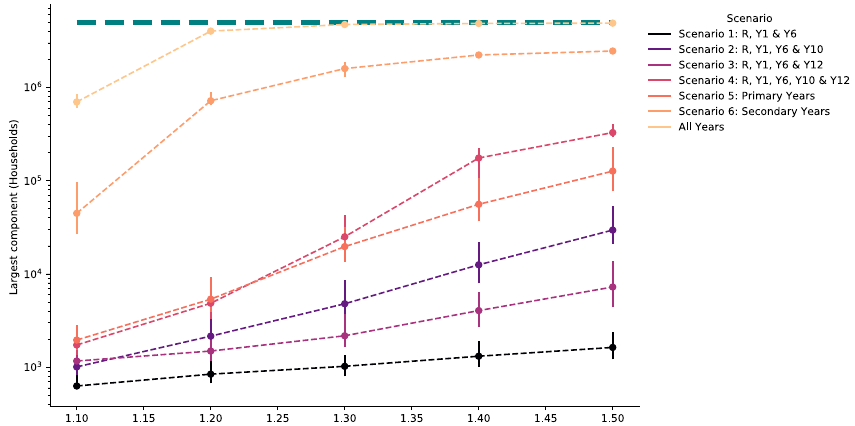
Fig. 4 Largest components of the binary outbreak networks. The number of households with children attending a school in each largest connected component of the binary transmission networks (estimated potential outbreak cluster size) generated from transmission probability networks for school reopening scenarios. The points show the median and error bars show the 90% credible intervals for 1000 realisations of binary outbreak networks. The green dashed line shows the total number of households in the school system